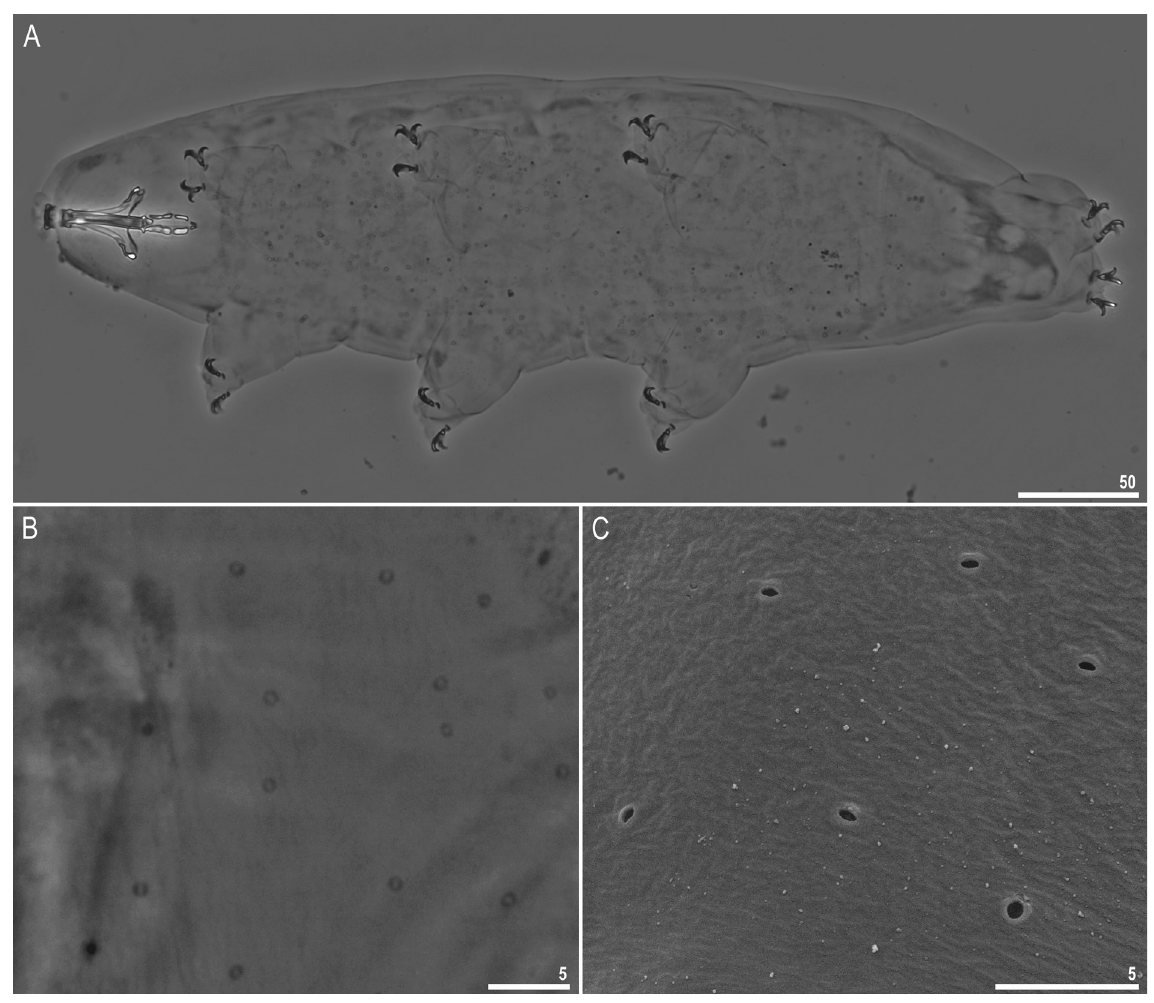
Fig. 1. Macrobiotus noongaris sp. nov., habitus. A . Dorso-ventral projection (holotype, Hoyer’s medium, PCM, IZiBB AU.031.12). B–C . Cuticular pores on the dorsal part of the body seen in PCM (B: holotype) and in SEM (C: paratype, IZiBB). Scale bars in